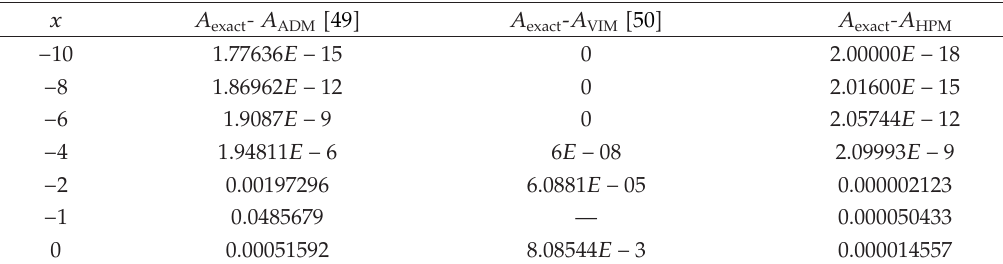
Table 2: Comparison between absolute errors of ADM, VIM, and HPM for t (cid:9) 0 . 01, c (cid:9) 3. x A